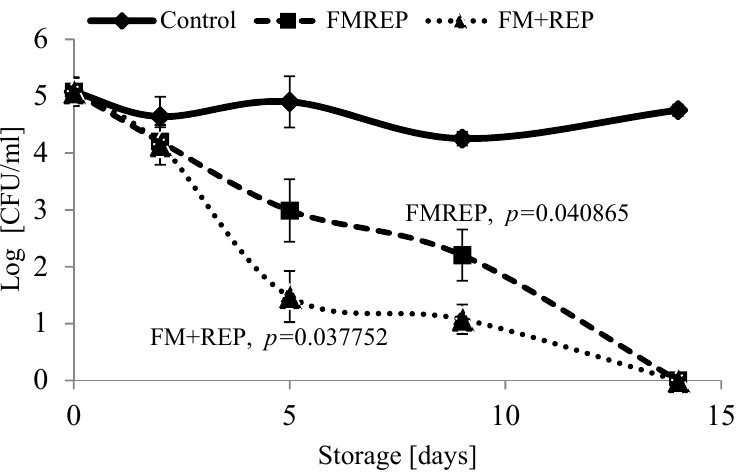
Figure 2. Effect of ellagitannins (10 mg/mL REP) on Geotrichum candidum viability in fermented milk during refrigerated storage (4 ° C). FMREP: milk fermented with ellagitannins, FM + REP: ellagitannins added after completed fermentation.